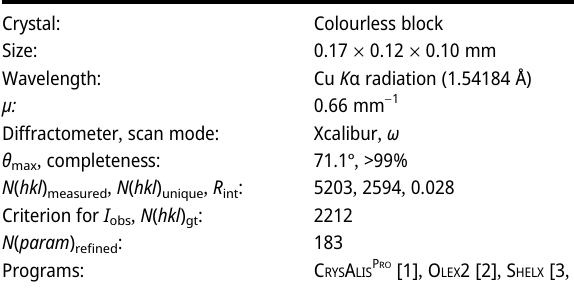
Table  : Data collection and